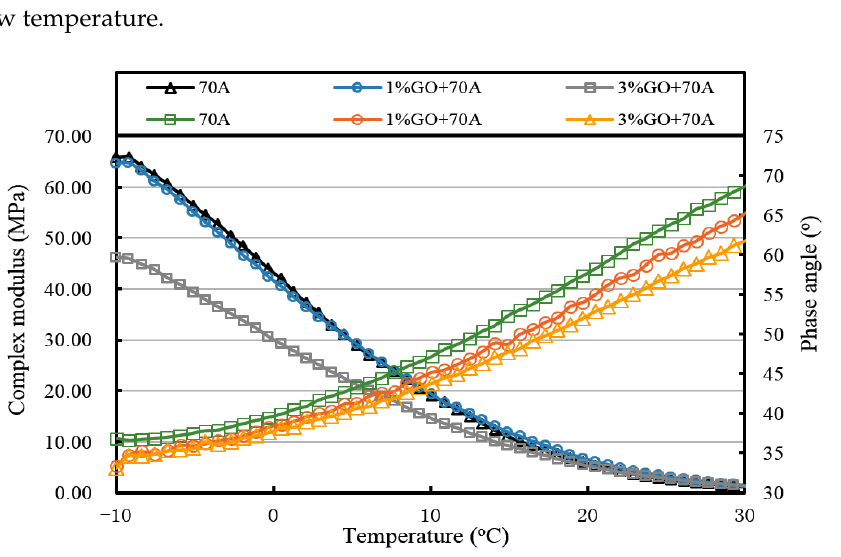
Figure 13. Complex modulus and phase angle of GO-modified 70A and its matrix at low temperature before aging.